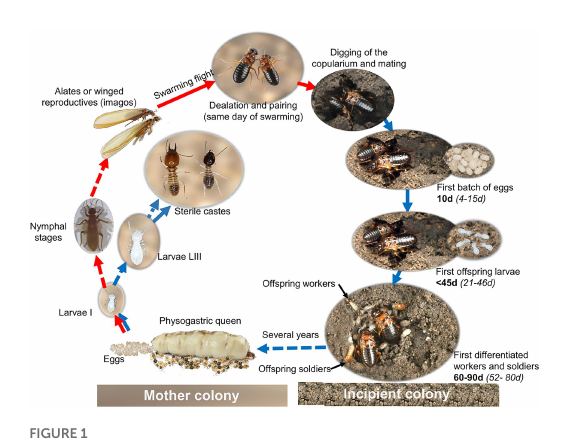
FIGURE 1 Simplified developmental cycle of Macrotermes subhyalinus. Red arrows indicate the developmental pathway for the reproductive caste. The chronology of the emergence of the offspring stages is indicated in bold from our own observations and in italic for Macrotermes sp. from